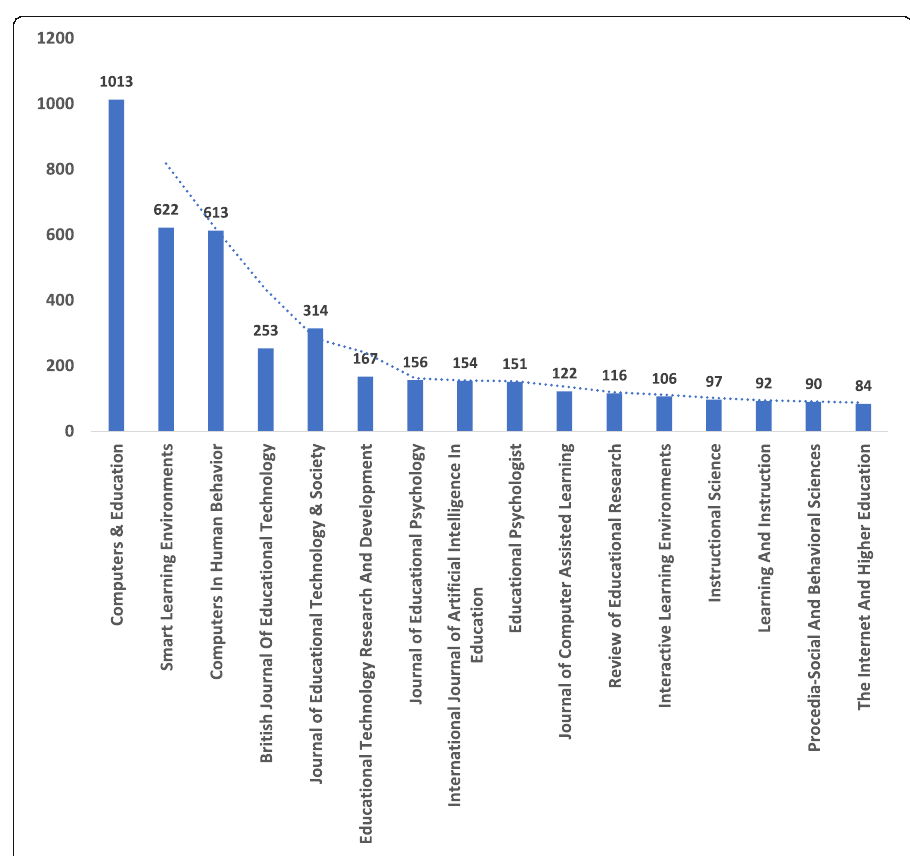
Fig. 3 Relevant publishing outlets with most local citations: Computers & Education , Smart Learning Environment , and Computers in Human Behaviour s stands